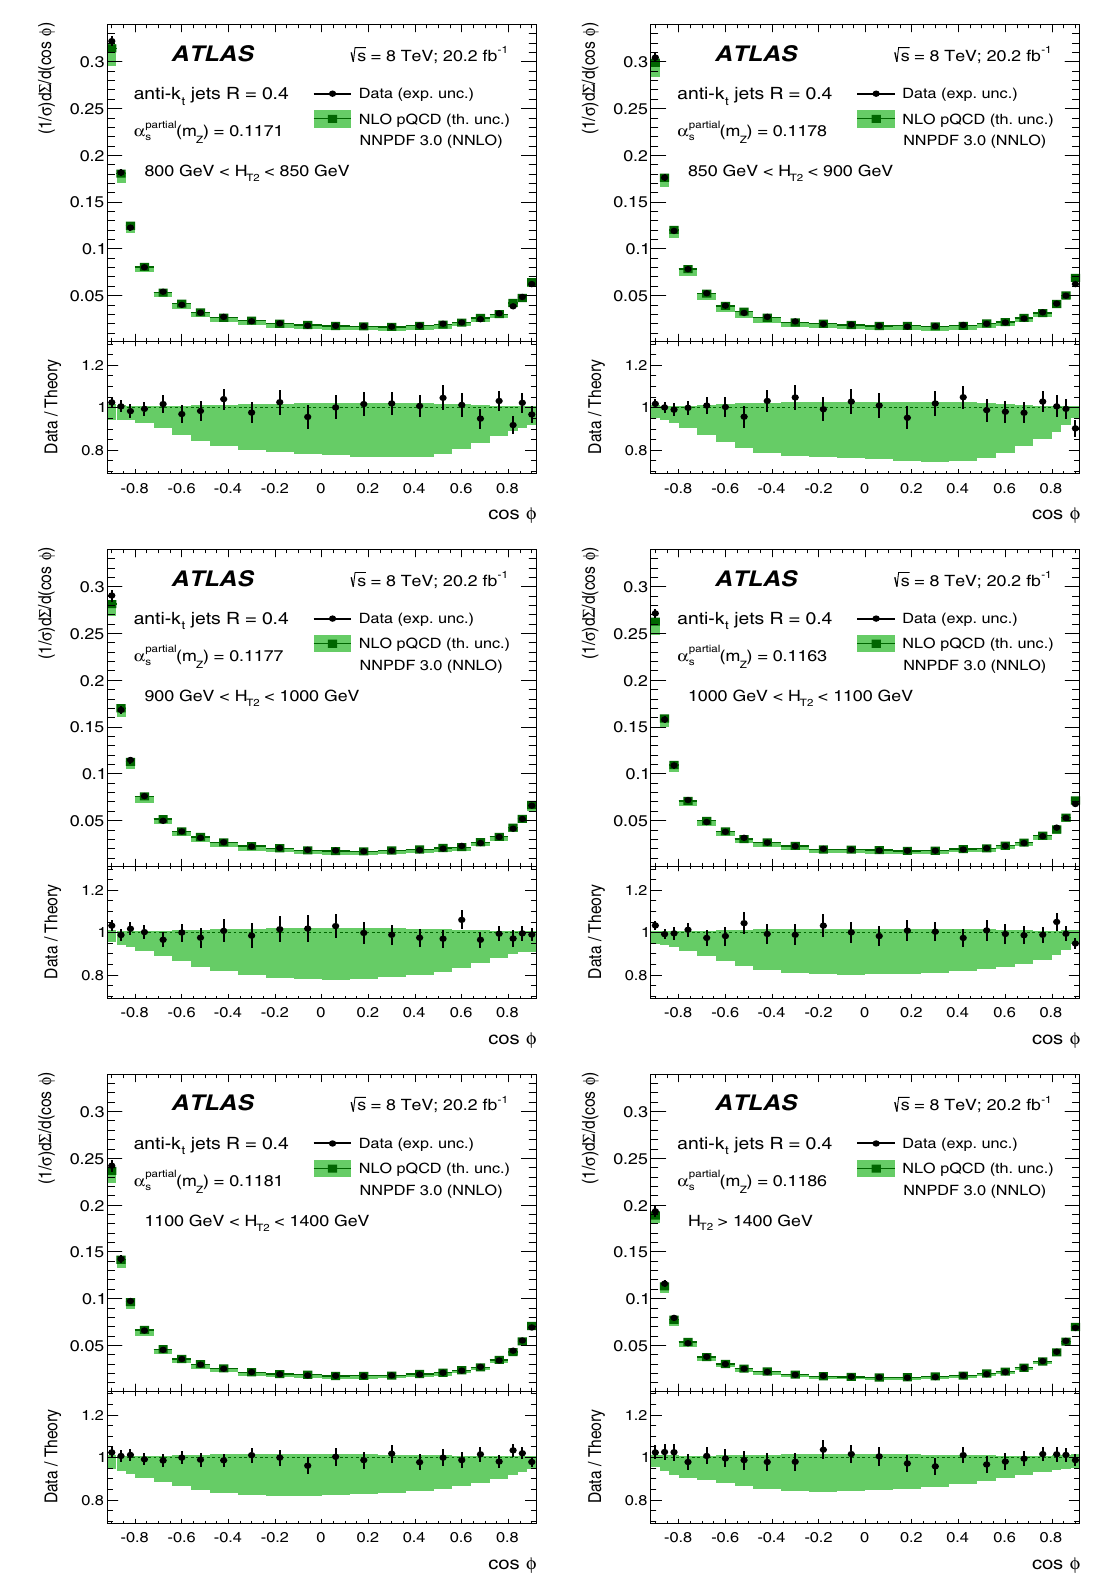
Fig. 8 ComparisonoftheTEECdataandthetheoreticalpredictionsafterthefit.Thevalueof α s ( m Z ) usedinthiscomparisonisfittedindependently for each energy